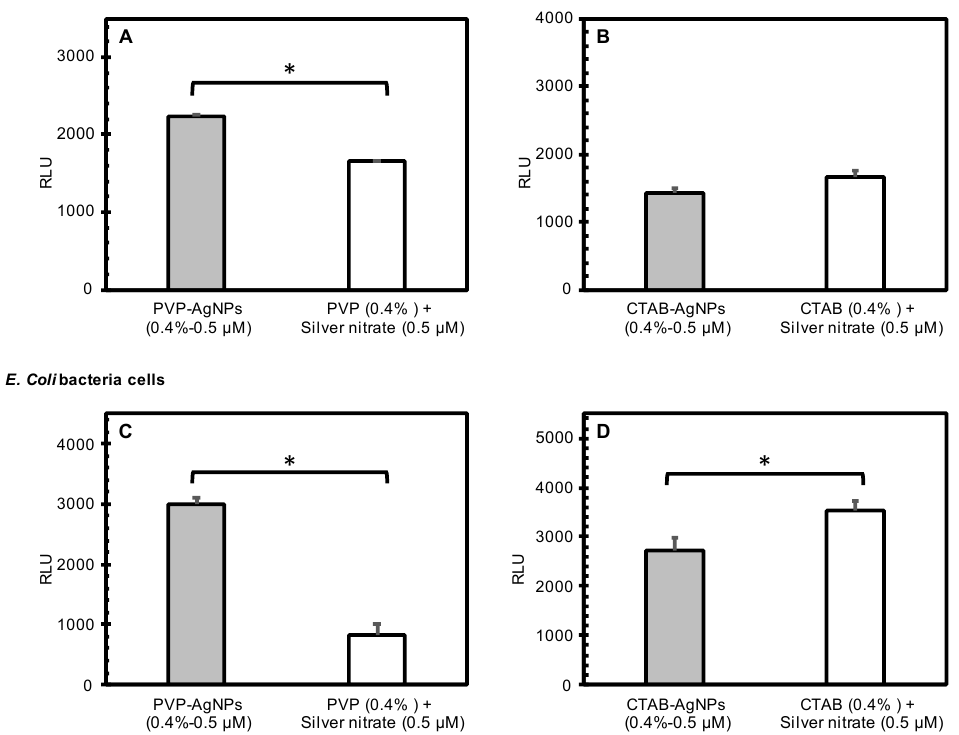
Figure 5. Comparison of the effects of surface-stabilized silver nanoparticles (measured) to the predicted cumulative effects of stabilizing agents and silver nitrate as calculated from independent component treatments. The graphs show the average RLU generated by treatment of BEAS-2B mammalian cells ( A , B ) and E. coli bacterial cells ( C , D ) with PVP-AgNPs (0.5 µM; ( A , C )) and CTAB-AgNPs (0.5 µM; ( B , D )). Error bars depict one standard deviation from the mean. Significantly different means are indicated by an asterisk ( p < 0.05).